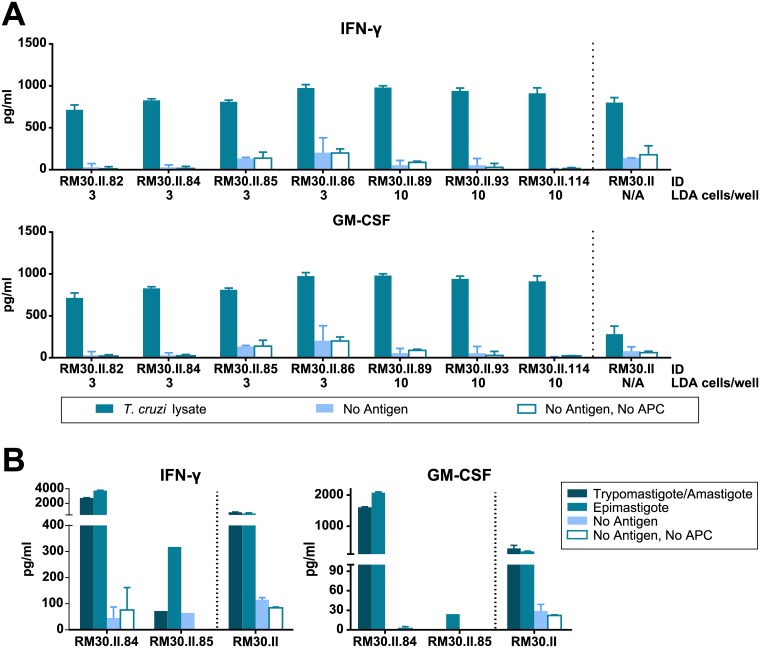
Antigen specific response in cultures resulting from limiting dilution assay (LDA) of culture RM30.II.A. Twenty-five thousand cells from each culture well were challenged with T. cruzi lysate, using 5×104 autologous overnight-primed B-LCL per well as APC. Specificity against T. cruzi antigens was assessed for several potentially monoclonal lines by IFN-γ and GM-CSF secretion. N/A: Non applicable. B. Specific response was tested using lysates from different stages in the parasite’s life cycle (epimastigote and trypomastigote/amastigote) for T cell lines RM30.II.84 and .85.